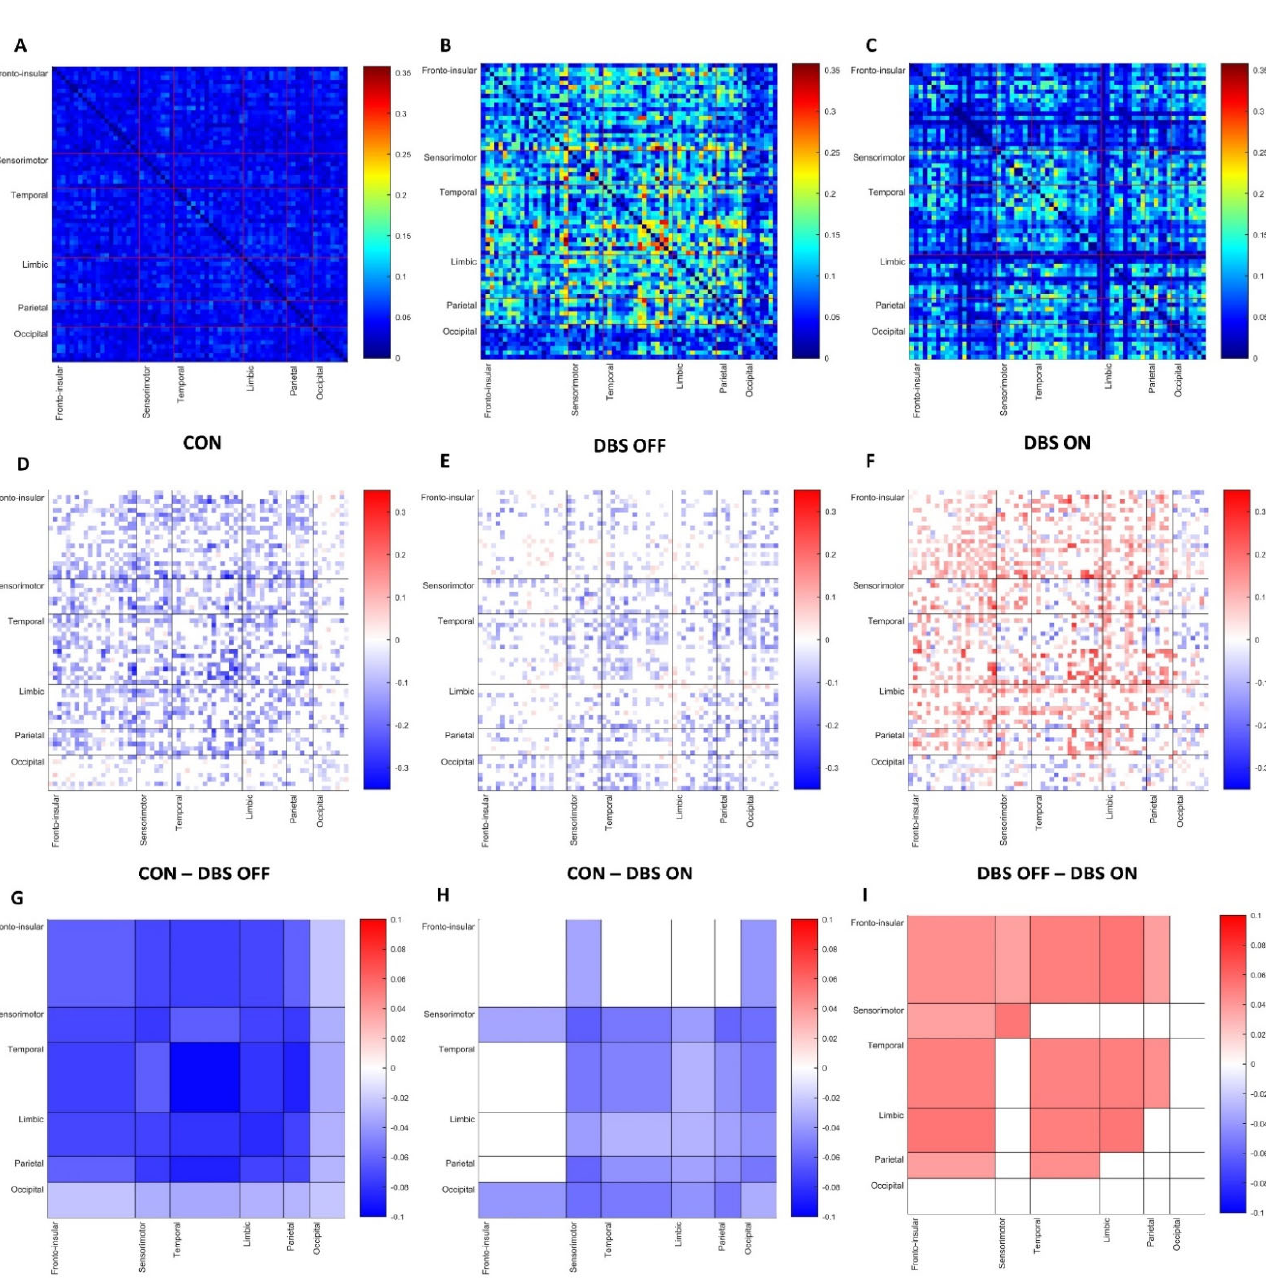
Figure 2. First row shows FC for each pair of ROIs based on wPLI, respectively, in HC ( A ) and PD patients STN-DBS-OFF ( B ) and STN-DBS-ON ( C ) in β frequency bands. Second row reports differences in FC of each pair of ROIs between HC and PD patients STN-DBS-OFF ( D ), HC and patients STN-DBS-ON ( E ) and between patients STN-DBS-OFF and STN-DBS-ON ( F ) in β frequency bands. Third row shows block-based differences in FC between HC and PD STN-DBS-OFF ( G ), HC and PD STN-DBS-ON ( H ) and between PD patients STN-DBS-OFF and STN-DBS-ON ( I ) in β frequency bands. Only differences with a p < 0.05 are shown. Table 2. Significant differences in block ‐ based mean β FC between DBS ‐ OFF and DBS ‐ ON conditions.